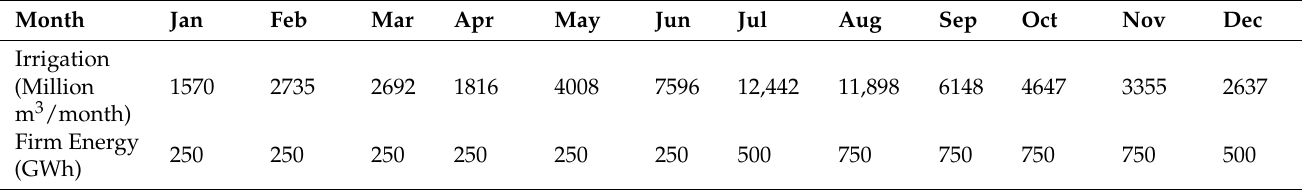
Table 1. Monthly energy demand profile of Tarbela Reservoir